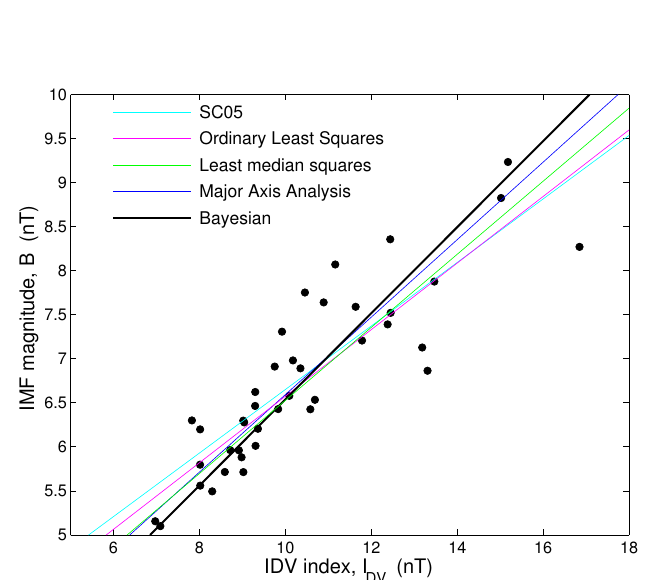
Figure 22: Scatter plot and best-fit linear regressions between the 𝐼𝐷𝑉 index and the IMF strength 𝐵 . The wide variety of regression slopes demonstrates the effect of the choice of regression method used. The light blue line is the fit by SC05, the other lines are the best-fit regressions by LEA06 for residual minimization methods of: (mauve line) Ordinary Least Squares (OLS); (green line) least median of squares